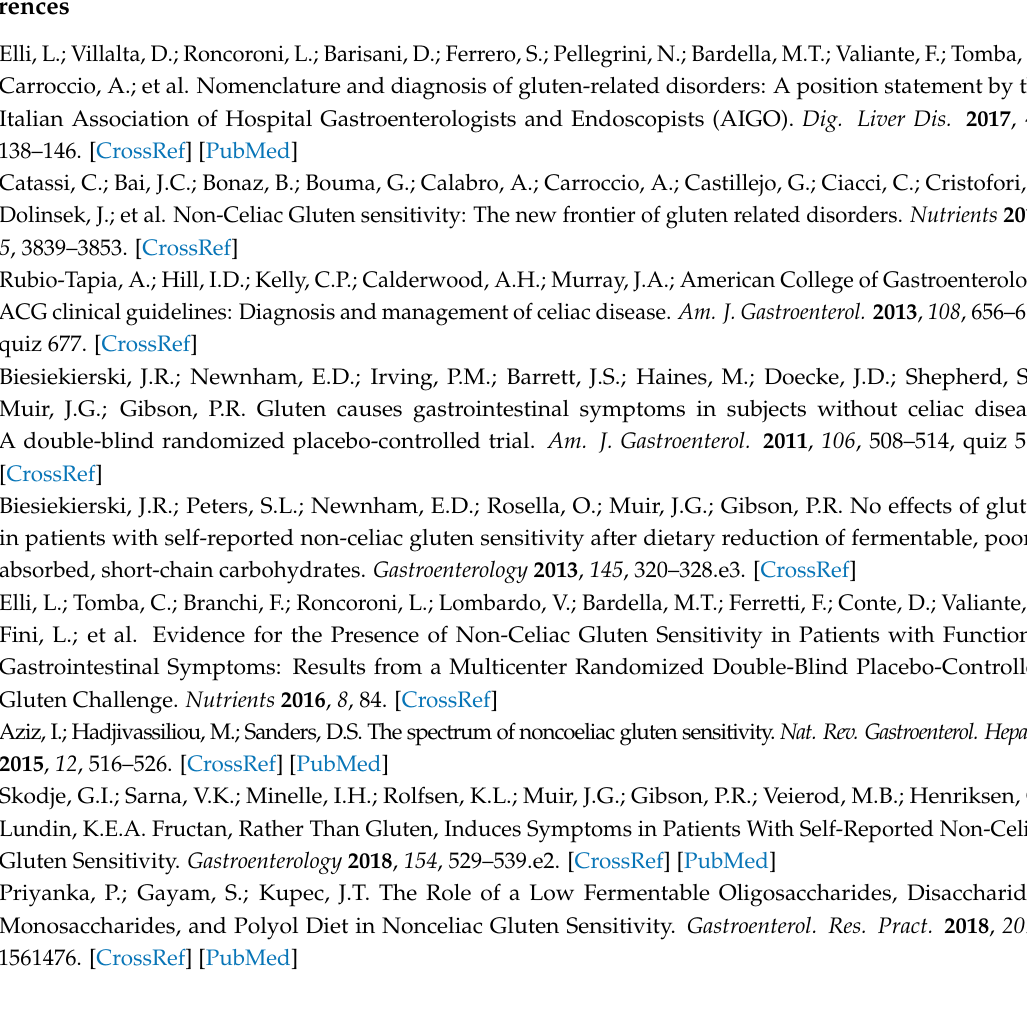
Table S1: scores for each item of the GSRS